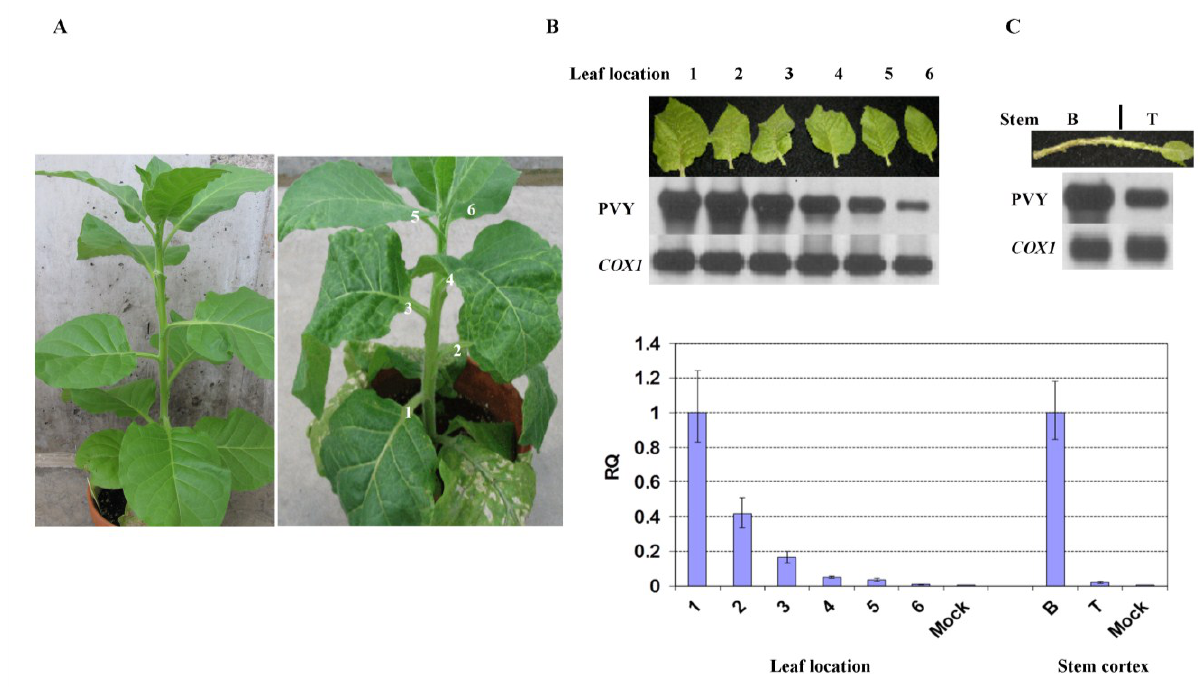
Figure 1. Recovery phenotype in tobacco plant after infection with PVY N:O -Mb58. ( A ) Symptoms in Potato virus Y (PVY)-infected plant (right) at 14 days post-inoculation (dpi). Left, mock-inoculated plant; ( B , C ) RT-PCR-Southern blot analysis of PVY level and COX1 in +1 to +6 leaves as well as stem cortex at the bottom (B) and top (T); ( D ) Real-time RT-PCR analysis of the relative PVY level (RQ) after normalization with the COX1 level in leaves and stem